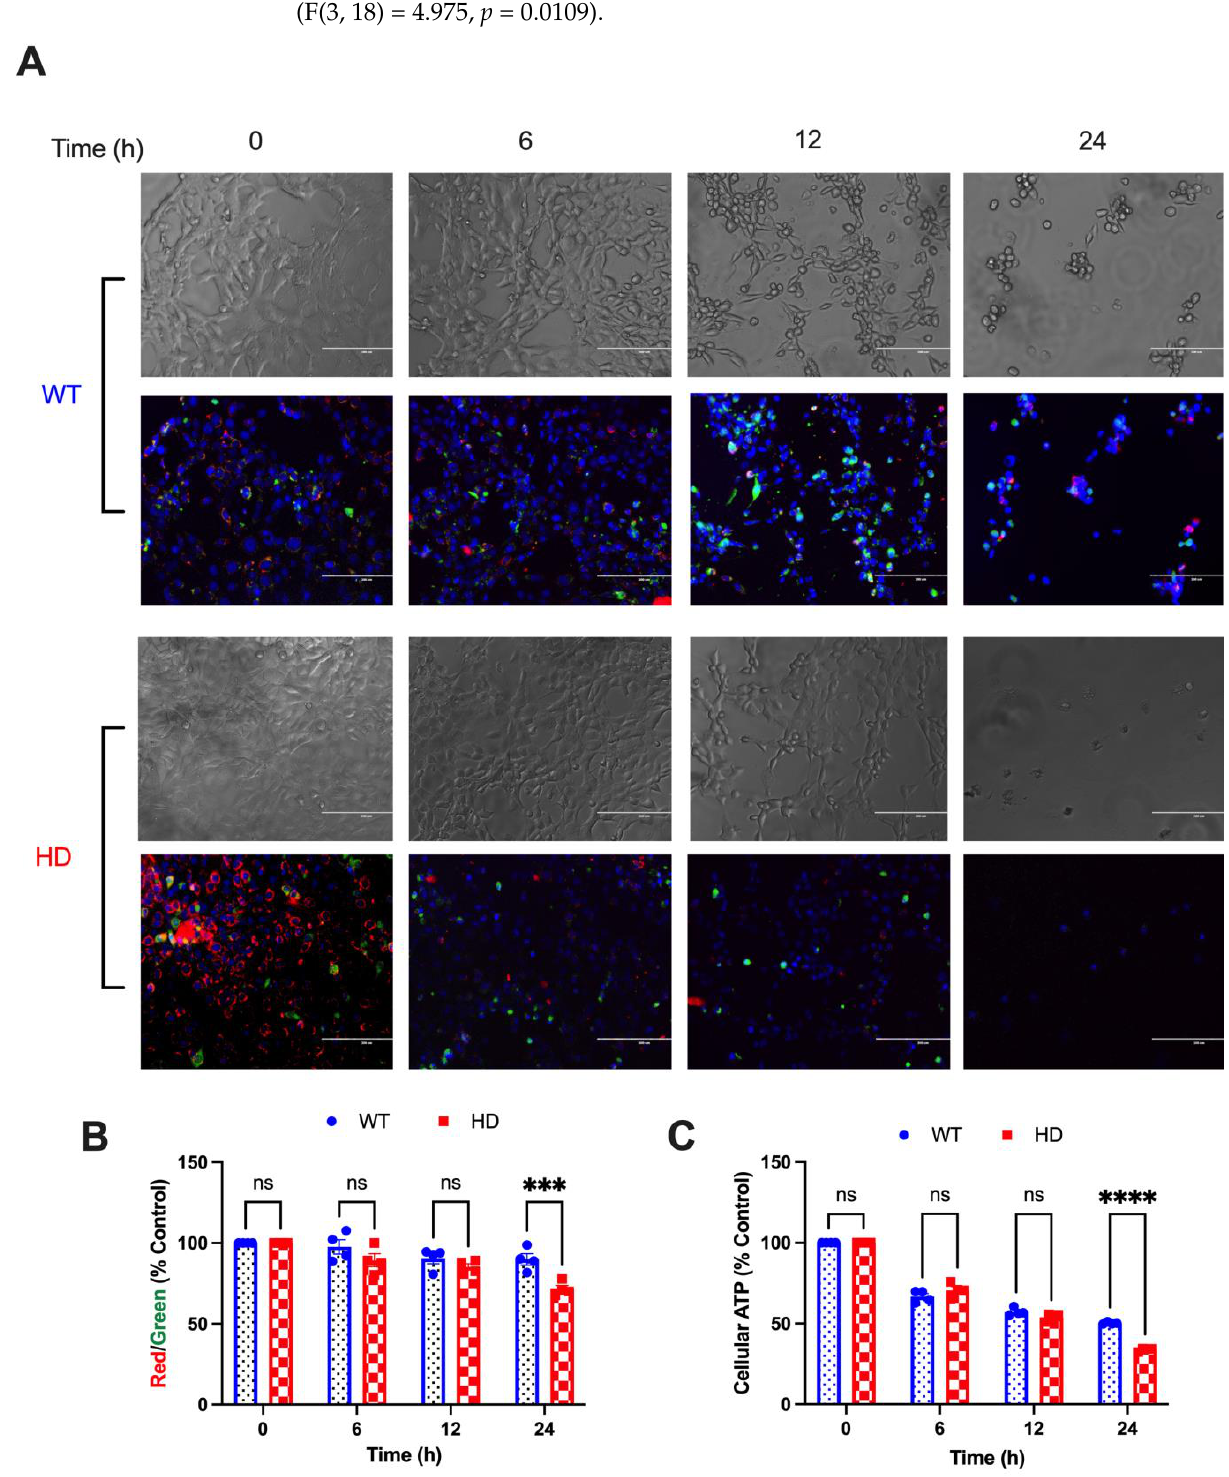
Figure 2. HD striatal cells exhibit reduced mitochondrial bioenergetics compared with WT upon acute Cd exposure. ( A ) Representative qualitative brightfield images of JC-1 dye (red J aggregates and green monomers) and Hoechst DNA stain (blue) staining, and ( B ) quantitative representations of MMP upon exposure to 40 µM CdCl 2 for 0, 6, and 24 h. MMP is represented as a ratio of red J-aggregates to green monomers normalized to its respective vehicle control. Results are represented by the mean ± SEM from four biological replicates (N = 4). ( C ) Cellular ATP measurement in WT and HD cells upon 40 µM Cd exposure at the indicated time points. Results are represented by the mean ± SEM from four biological replicates (N = 4 ). Sidak’s multiple comparison test compared the